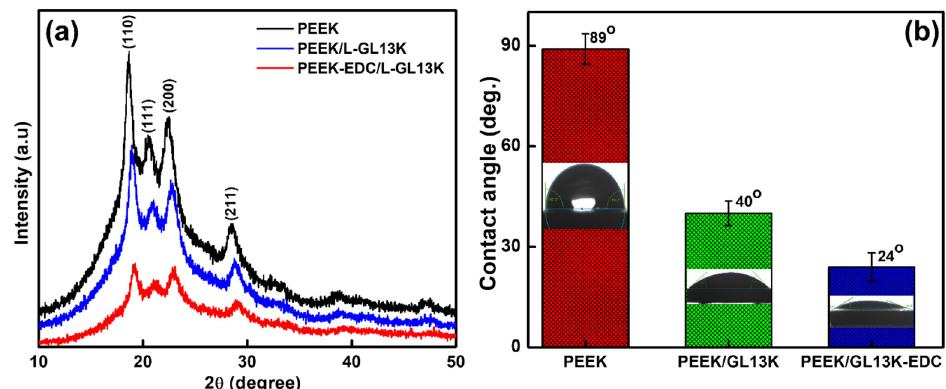
Figure 3. ( a ) X-ray diffraction (XRD) and ( b ) contact angle measurements for PEEK, PEEK/GL13K, and PEEK/GL13K-EDC samples. At least three different spots on each sample surface were measured, and the average values are presented with standard deviation ( n = 3).